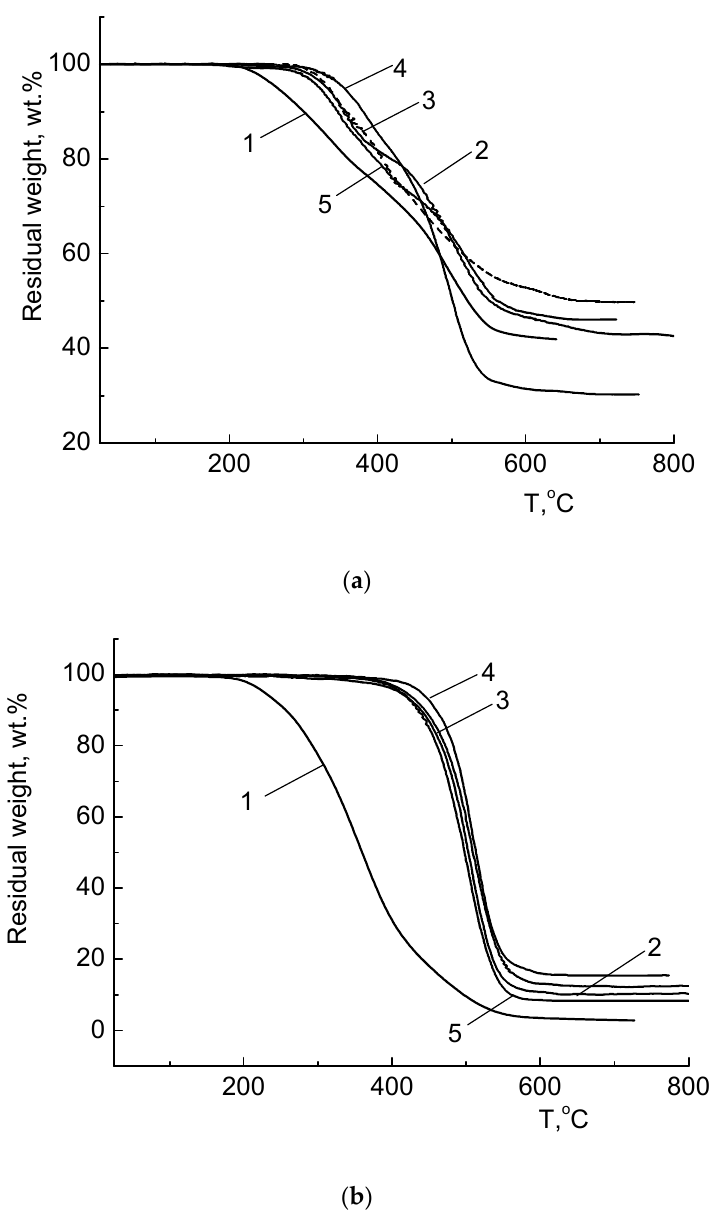
Figure 5. TGA curves for PDMS-15 ( 1 ) and Ph 4 -15 ( 2 ), Ph r 4 -15 ( 3 ), Tol 4 -15 ( 4 ), Me 4 -15 ( 5 ) star-shaped polymers both in air ( a ) and in argon ( b ) at 10 °C/min heating rate.